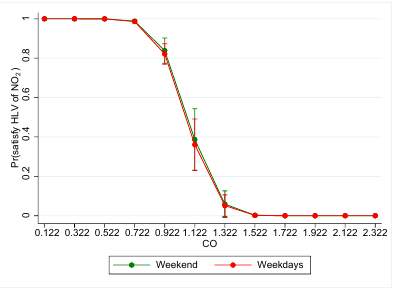
Figure 13. Impact of CO with segmentation between weekdays and the weekend.